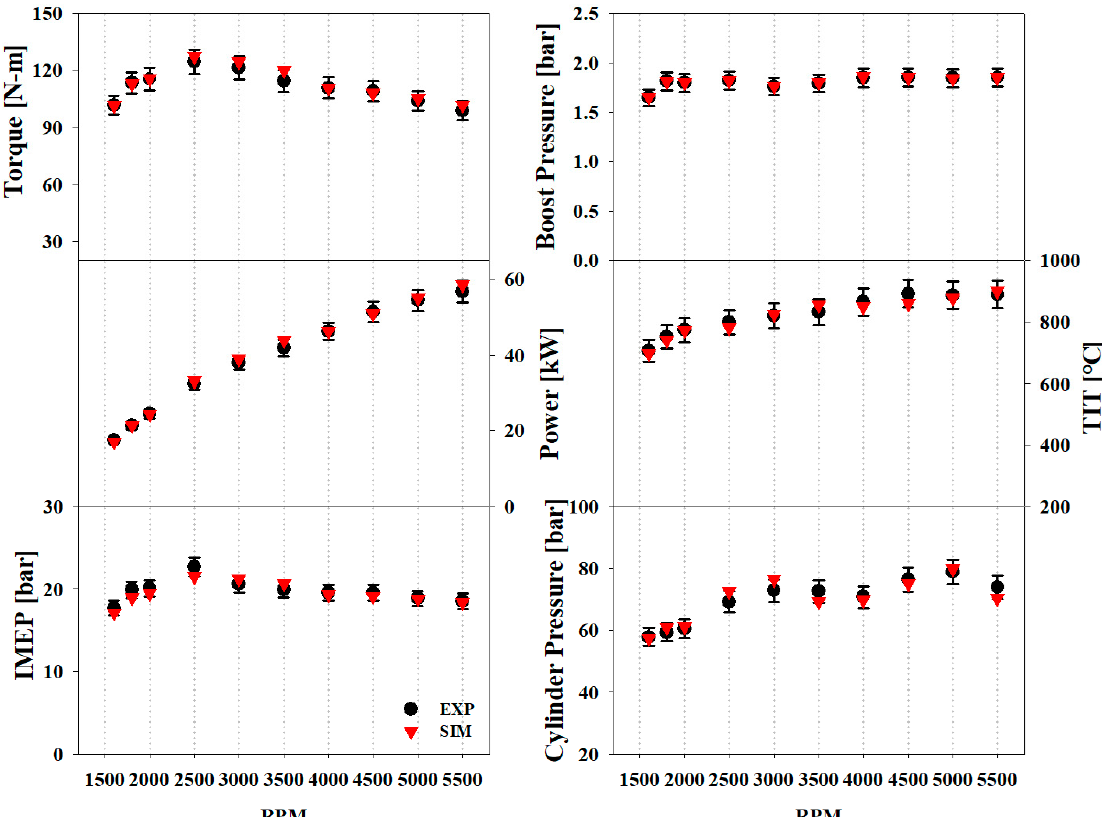
Figure 5. Reference 1D model simulation results ( ±5% ).